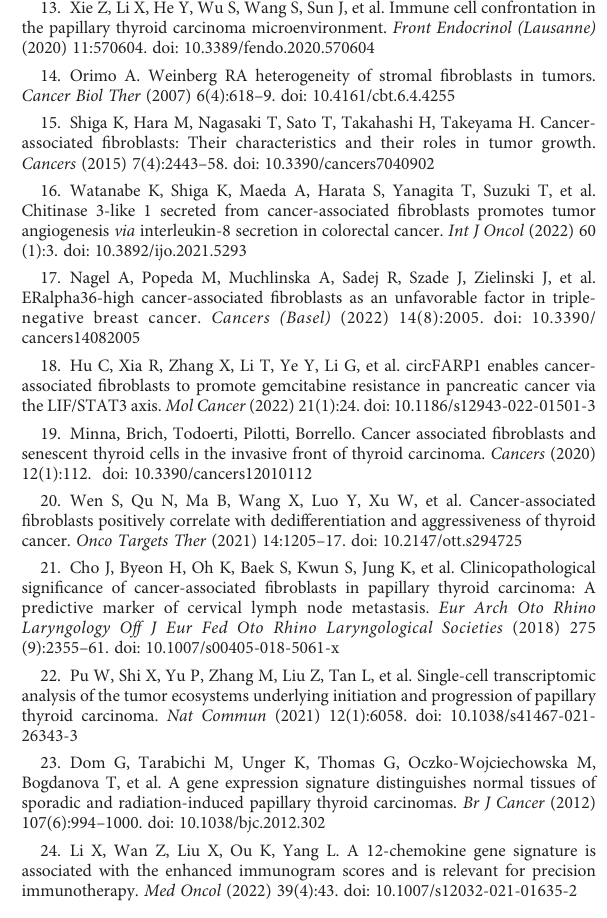
Proportions of different cell clusters in each sample tissue. (C) Integrated cell-cell communications network plotted by interaction numbers. (D) Cell-cell communications network of each cell cluster. SUPPLEMENTARY FIGURE 2 Cell-cell communications heatmap in thyroid cancer. (A) The heatmap of incoming and outgoing signaling patterns. (B) The heatmap of MIF signaling pathway network. SUPPLEMENTARY FIGURE 3 Expression heatmap of fi broblast related genes and fi brosis scores in TCGA-THCA dataset. (A) The expression heatmap of FRGs between normal and tumor thyroid cancer. (B) The samples in TCGA-THCA dataset were divided into high and low fi brosis groups based on the median score. SUPPLEMENTARY FIGURE 4 Immune cells in fi ltration and 6 key genes analysis in thyroid cancer patients. (A) Immune cells in fi ltration proportions in each thyroid cancer patients. (B) Expression levels of PCOLCE2, APOD, APOE, TIMP1 and HTRA3 in GSE33630. (C – F) The expression of MT1A was not found in this cohort. Kaplan – Meier plots showed the expression of APOD, APOE, MT1A and TIMP1 were not associated with overall survival of thyroid cancer